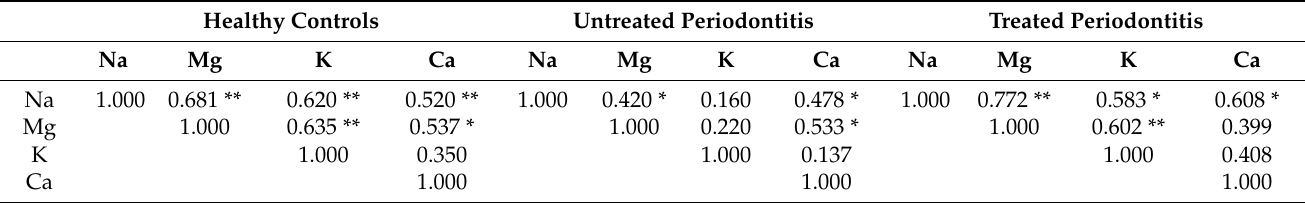
Table 5. Correlation matrix of mineral elements in saliva according to the periodontal conditions. Healthy Controls Untreated Periodontitis Treated